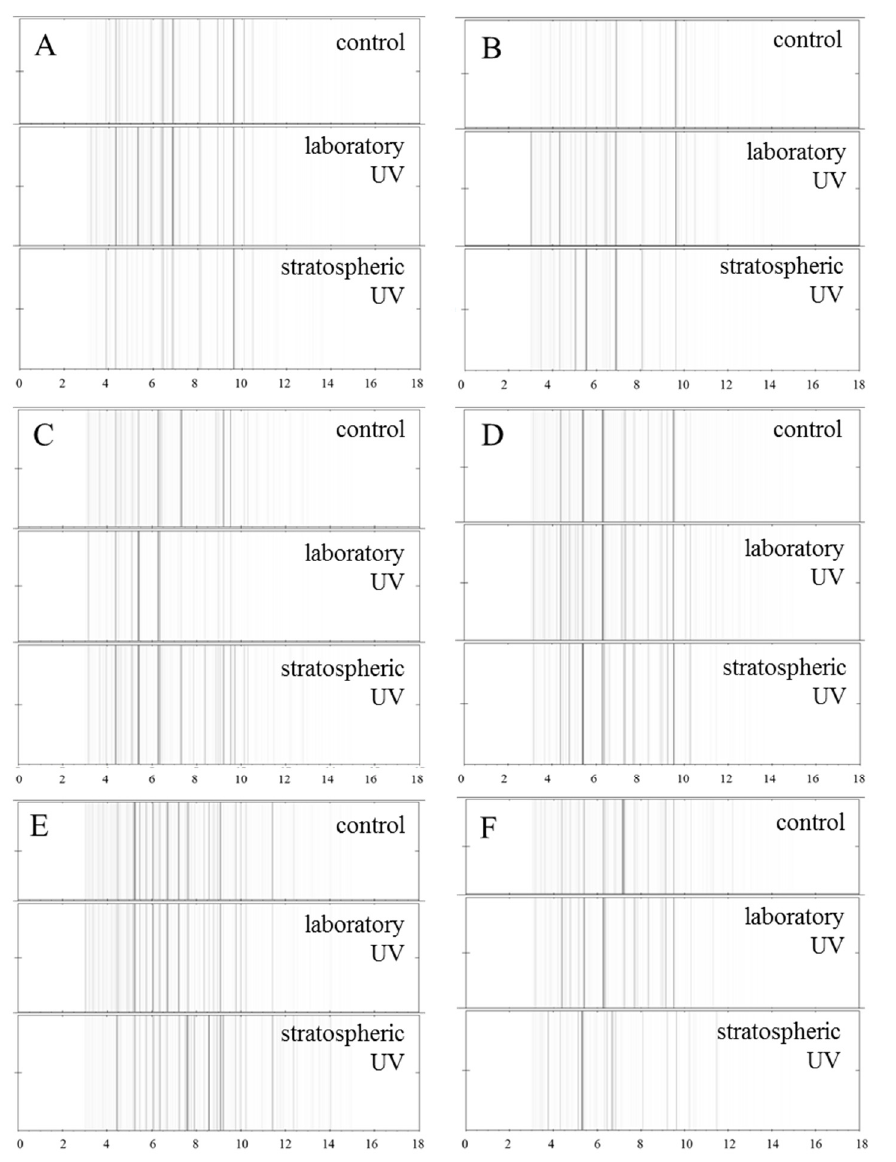
Figure 5. Pseudo-gel view comparison of MALDI-TOF MS spectra of bacteria without UV exposure, after exposure to the laboratory and stratospheric UV as ( A ) S. aureus , ( B ) MRSA, ( C ) E. coli , ( D ) S. typhimurium , ( E) P. mirabilis and ( F ) P. aeruginosa . Data were collected in the m/z range 2.000–20.000. For MALDI-TOF analysis, 1 µL of extract of each bacterial culture was used. The control samples were identified by MALDI BioTyper TM